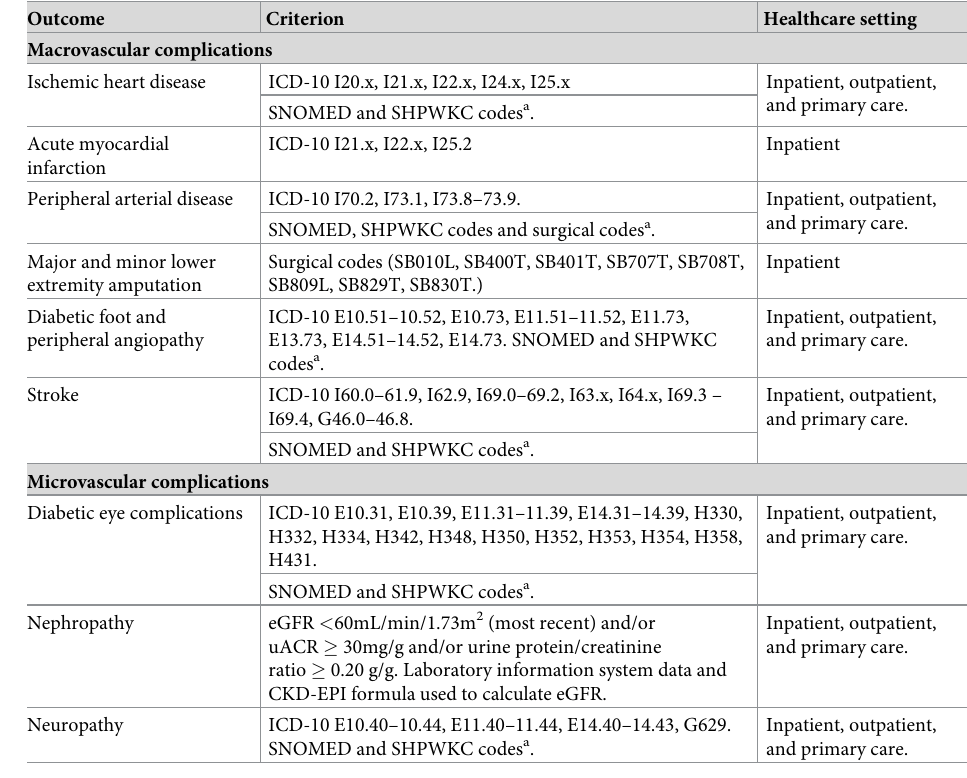
Table 1. Criteria used for outcome